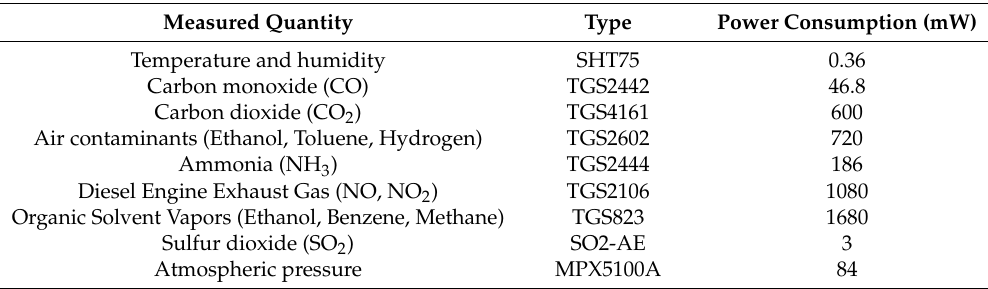
Table 3. Selected sensor parameters.